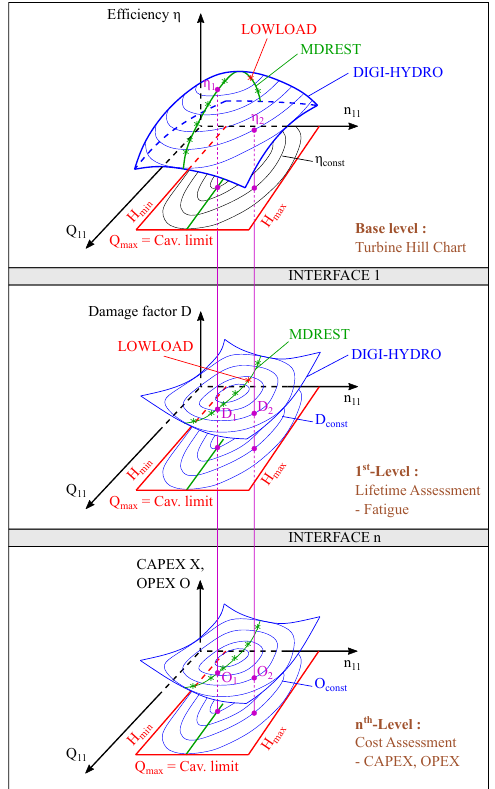
Figure 15. Multilevel